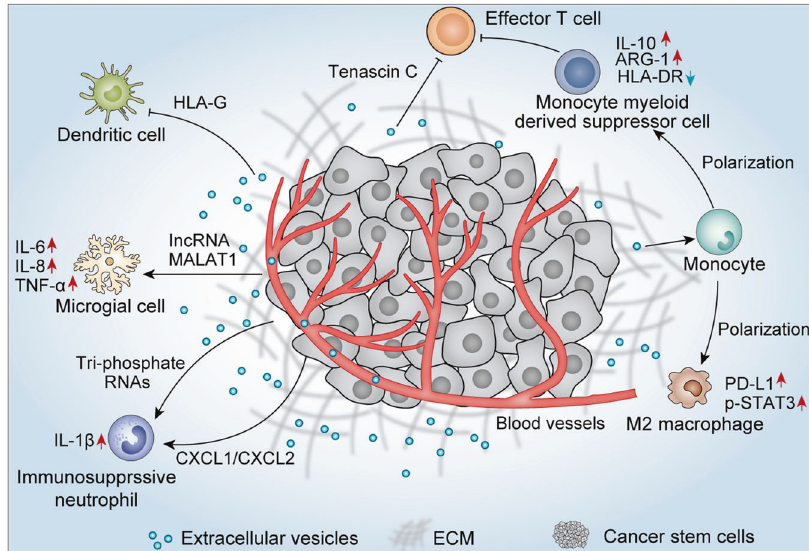
Fig. 4 Cancer stem cells-derived EVs promote the formation of tumor immunosuppression microenvironment. EVs secreted by CSCs exhibited a tumor immunosuppression microenvironment through inhibiting the survival and proliferation of effector T cells and dendritic cells, as well as inducing the production of M2 macrophage, immunosuppressive monocytes, and